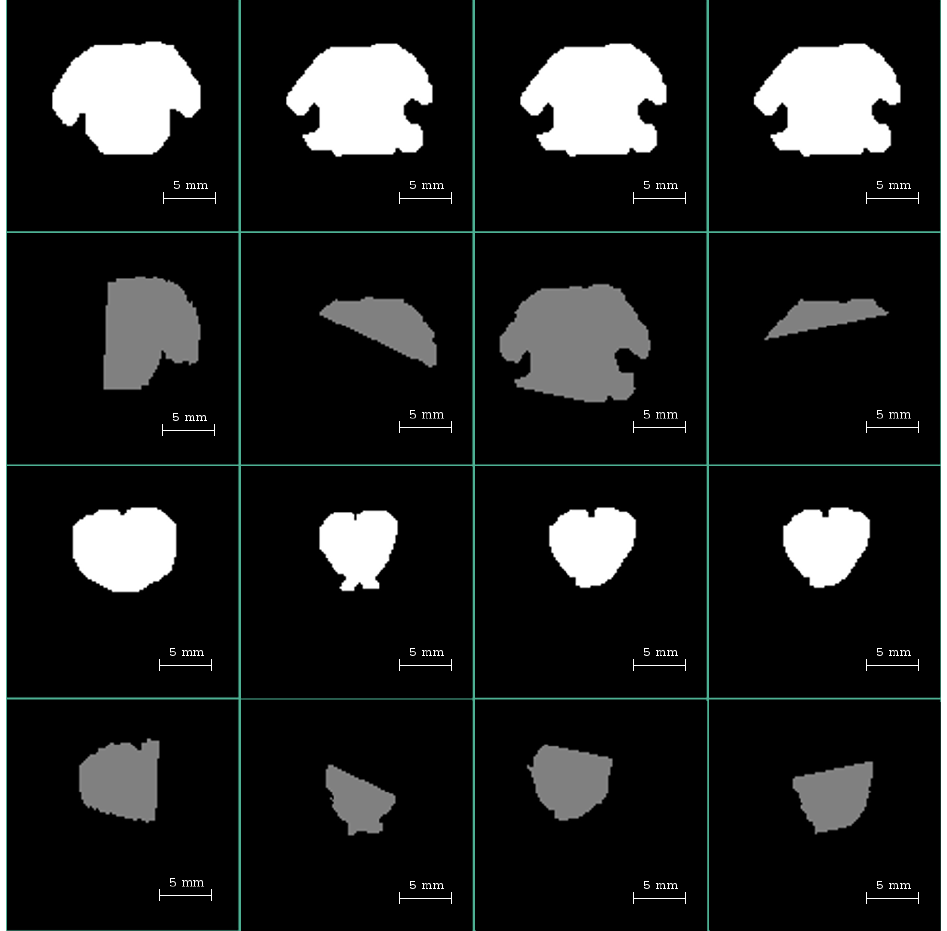
Figure 1: Rotational evidence in axial slices (stripping masks). These random-angle-cutting effects are only present at staring and ending slices of the rigidly-registered stacks. Rows 1 and 3 are the model’s masks, while rows 2 and 4 are their back-registered versions. The columns correspond to different acquisitions. The heterogeneous cutting angles suggest rotations in more than one axis. Column 3 is an example of acquisition not only rotated but dramatically moved in the